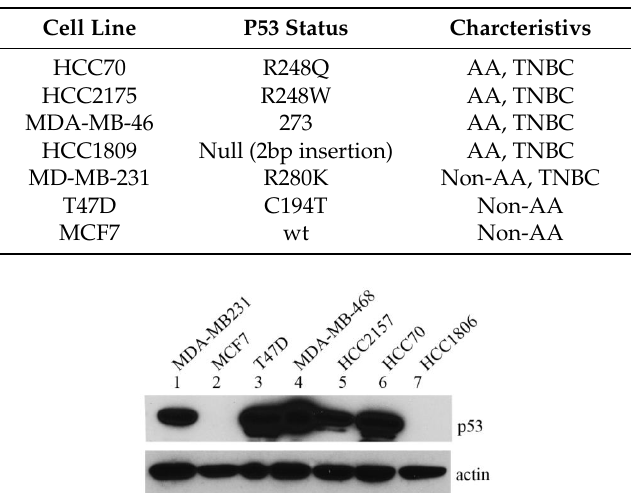
Table 1. Panel of breast cancer cell lines. Types of human breast cancer cell lines used for comparison of p53 protein expression levels. TP53 mutation status and cell line characteristics are listed. Cell Line P53 Status Charcteristivs HCC70 R248Q